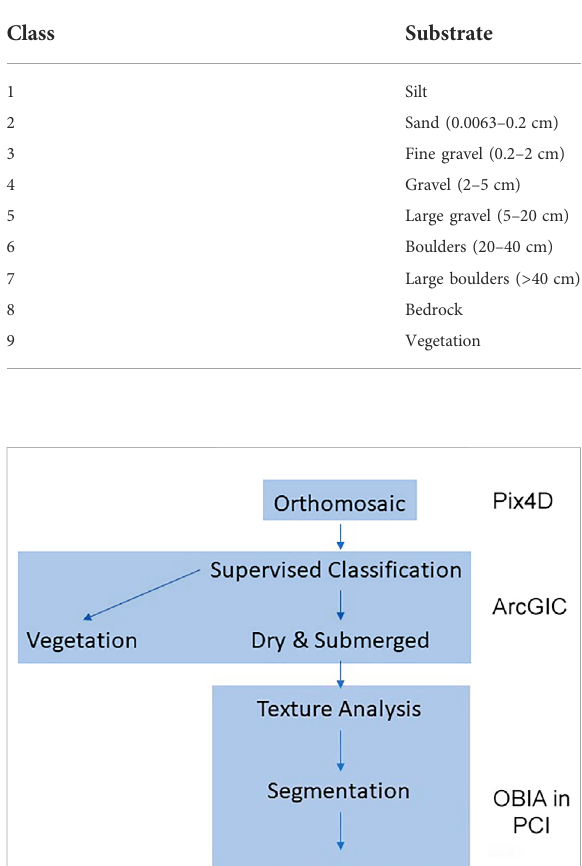
TABLE 1 Size classes used to classify substrate for the ground truth data.